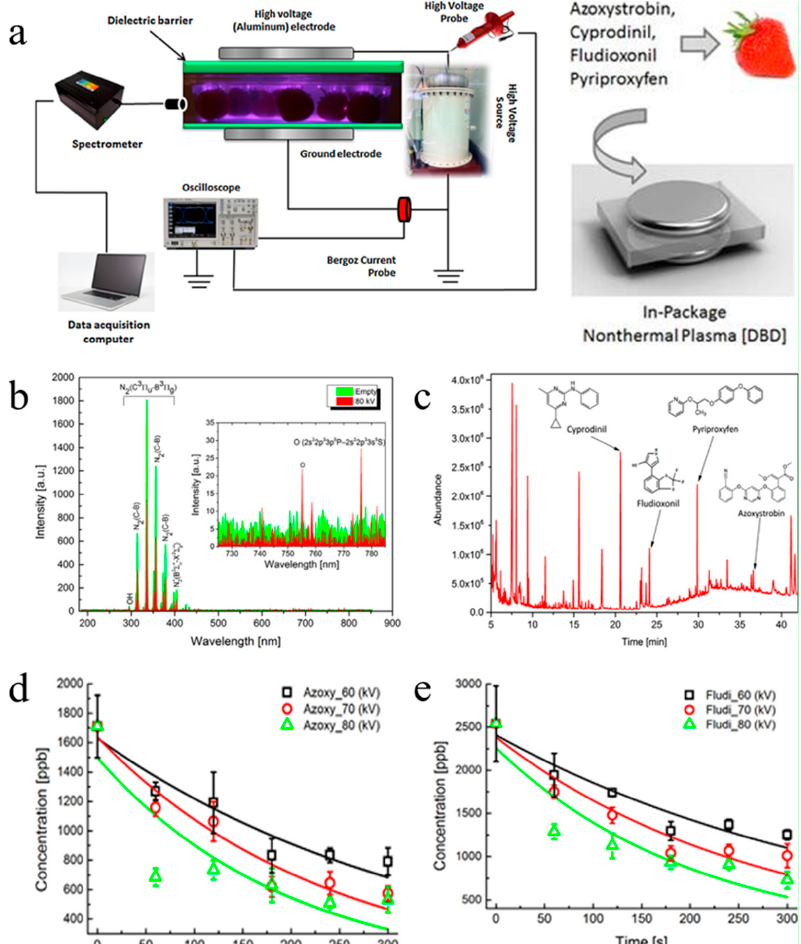
Figure 15. ( a ) the diagram of the DBD experimental device; ( b ) emission spectrum with or without strawberries; ( c ) retention times chromatogram of the four pesticides; ( d ) azoxystrobin concentrations before and after plasma treatment; ( e ) fludioxonil concentrations after plasma treatment. Reproduced with permission from [162]; Copyright Elsevier, 2014.